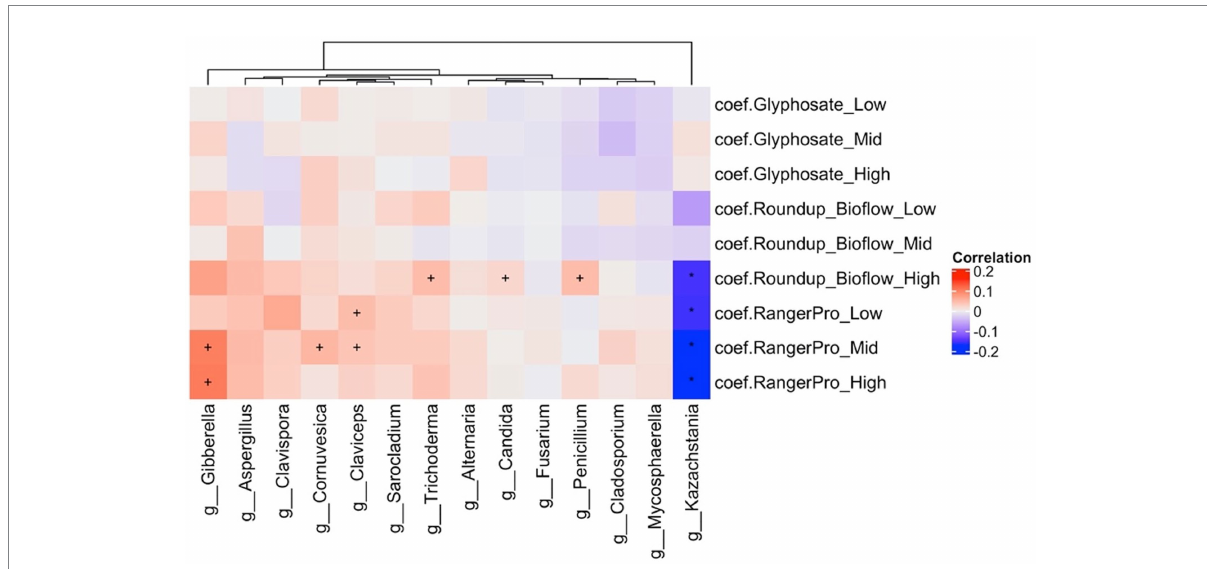
FIGURE 4 The formulations Roundup Bioflow and RangerPro alter the caecum mycobiome in rats. Male and female Sprague–Dawley rats were exposed to glyphosate or the herbicide formulations at 0.5, 5 and 50 mg/kg bw/day glyphosate starting at mid-gestation and ending at 13 weeks post- weaning. The figure shows a heat map of statistically significant differences in abundance caused by the exposure to the tested herbicides in the caecum mycobiome. The colour scale is the effect size from a multivariate association analysis showing if a fungal genera is more (red) or less (blue) abundant than in the control group. The statistical significance is the FDR indicated by symbols (***FDR < 0.001; **FDR < 0.01; *FDR < 0.05; FDR <